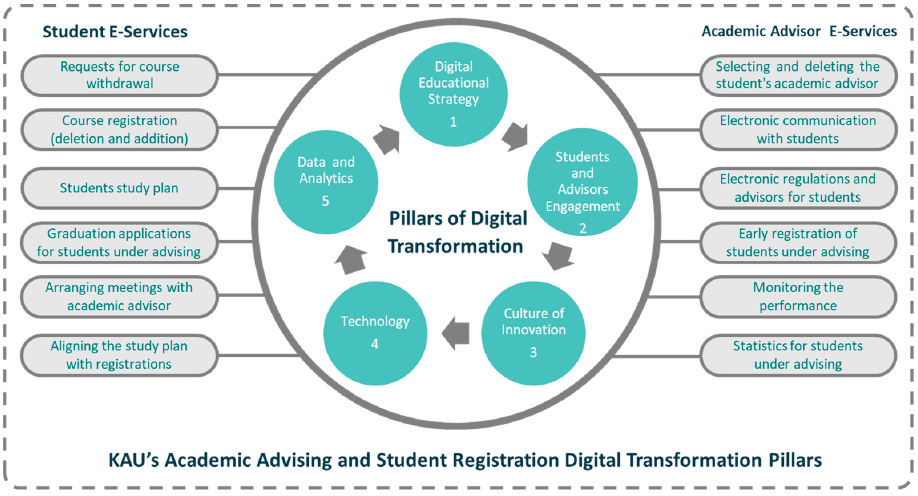
Figure 1. KAU’s e-services that connect students and academic advisors investigated in this research.